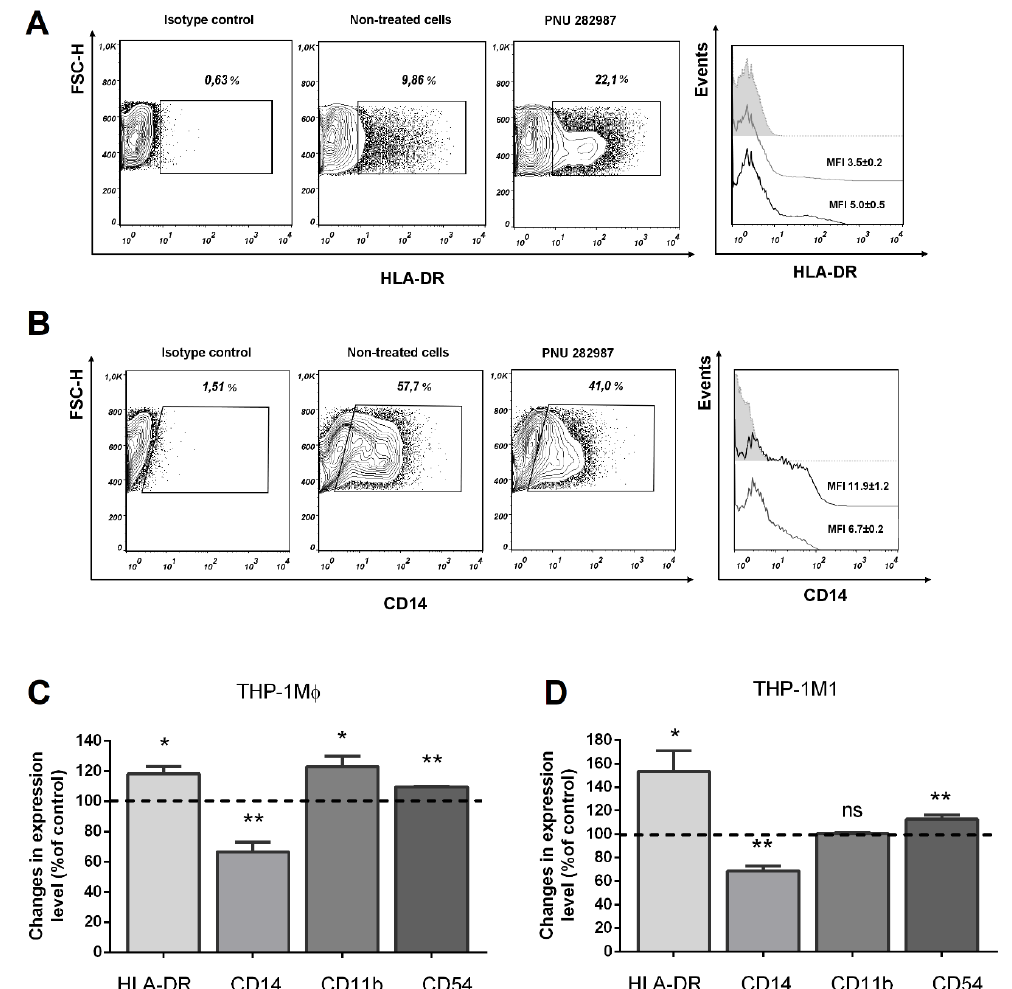
Figure 5. Representative expression profile of HLA-DR and CD14 on THP-1 macrophages and e ff ects of PNU 282,987 on the expression of membrane receptors involved in the inflammation on THP-1M φ and THP-1M1 cells. Cells were treated with PNU 282,987 for 48 h and analyzed by flow cytometry. PNU 282,987 led to an ( A ) increase in the proportion of fluorescence and the number of HLA-DR positive cells with ( B ) a decrease in CD14 expression. Histograms: gray dashed—isotype control; black line—control cells; gray line—PNU 282,987 treated cells. The numbers in the histograms represent MFI ± SEM (geometric mean in the entire cell population). The changes were observed in the expression level of the membrane proteins HLA-DR, CD14, CD11b, and CD54 on ( C ) THP-1M φ and on ( D ) THP-1M1. Stimulation of cells by PNU 282,987 also led to the increased expression of CD54 cell adhesion molecules and of the complement receptor CD11b. Data were obtained in three independent experiments and presented as mean ± SEM. Student’s t -test: * p < 0.05, ** p < 0.01 and ns p > 0.05 compared to untreated control